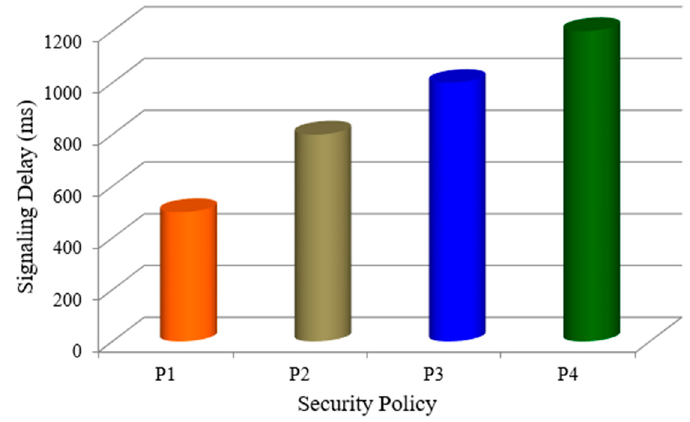
Figure 8. Signaling delay in each security policy of the proposed SIF.